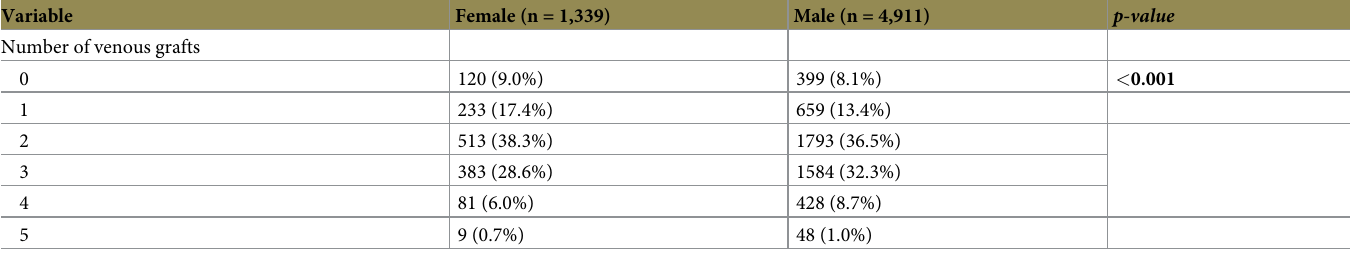
Table 2. Outcomes of CABG stratified by sex and multivariable regression analysis showing odds of developing post-operative complications following CABG in female patients with males as reference.